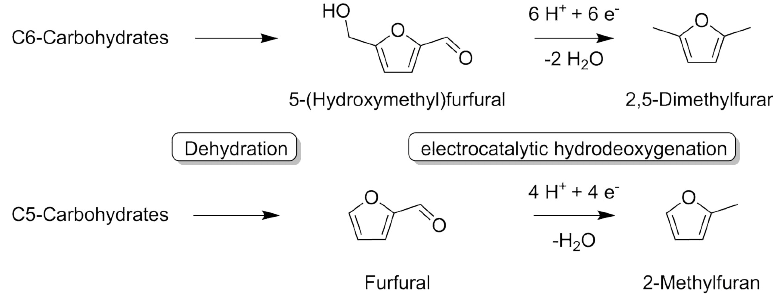
Figure 2. Schematic illustration of the electrocatalytic hydrogenation of 5-(Hydroxymethyl)furfural and furfural to 2,5-dimethyl-furan and 2-methyl-furan